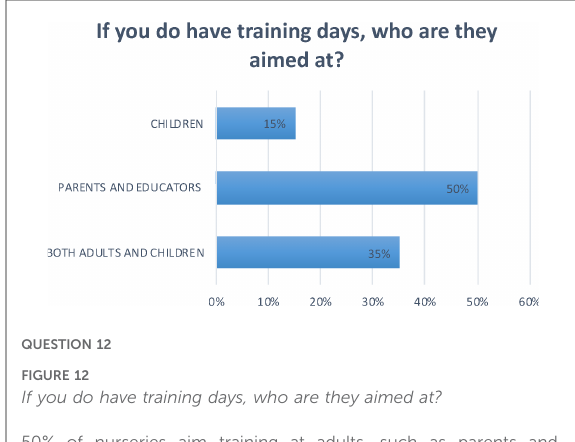
FIGURE 14 Would you be interested in a training day with a dental hygienist? 80% replied yes; 20% replied